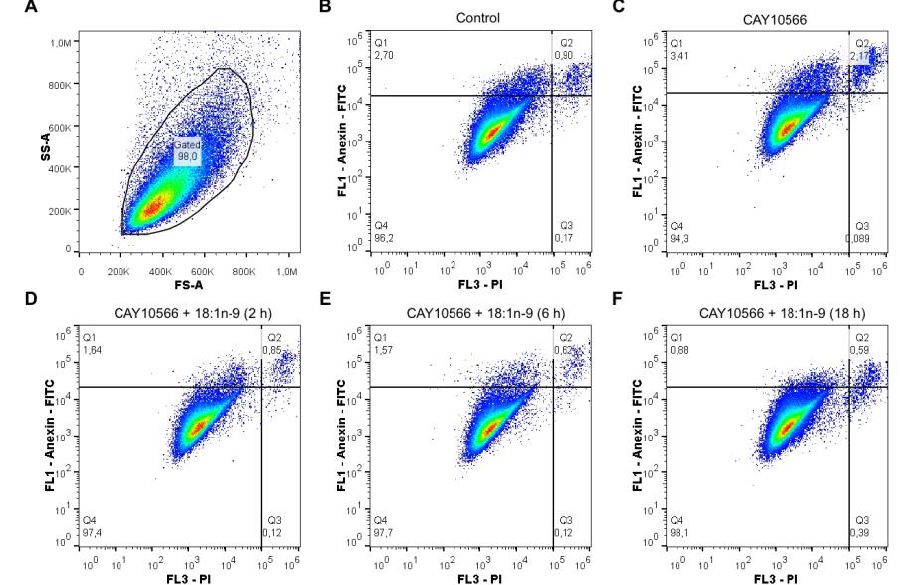
Figure 6. Analysis of the apoptotic markers in Caki-2 cells treated with a SCD-1 inhibitor and 18:1 n -9. Apoptotic changes in the plasma membrane were detected by simultaneous staining with annexin V-fluorescein isothiocyanate (FITC) (FL1) and propidium iodide (PI; FL3) ( A ) Gating strategy in the control and treated cells. ( B , C ) Cells were untreated (control) or treated with 3- µ M CAY 10566, respectively. ( D – F ) Afterward, 18:1 n -9 (50 µ M) was added to the cells at 2, 6 and 18 h,